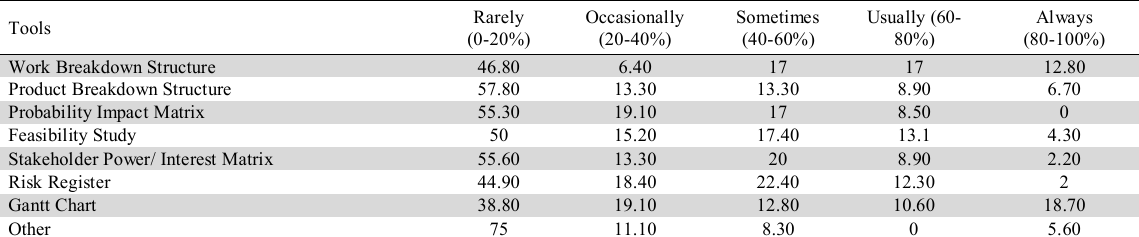
Frequency of usage in each tool (%) Tools